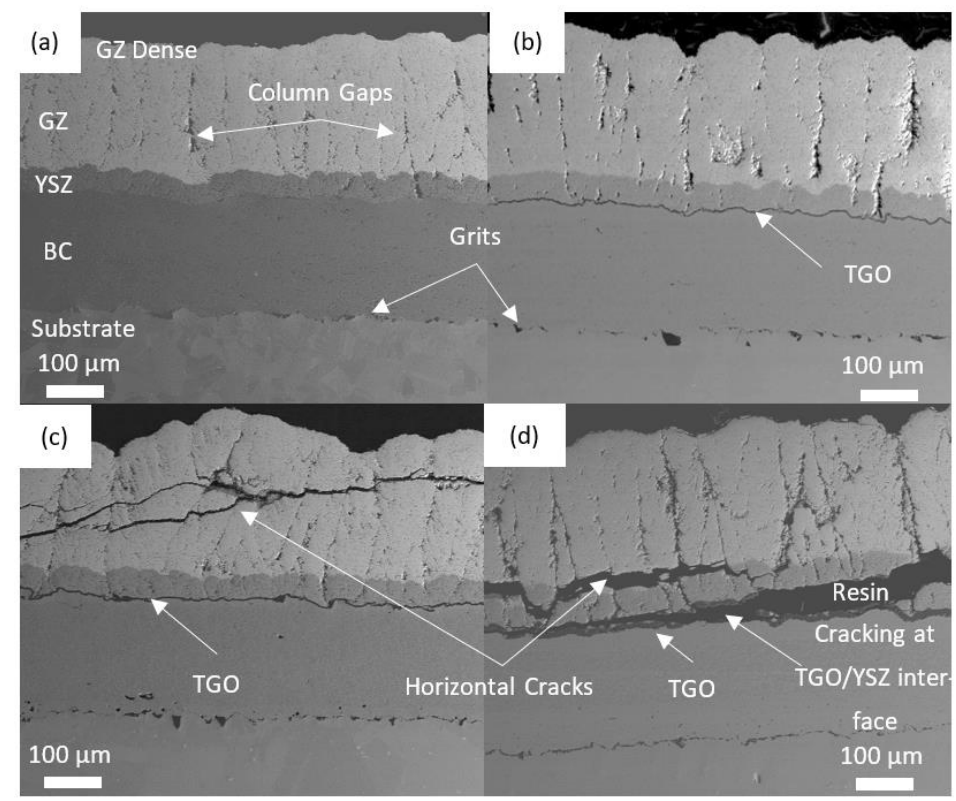
scale. Figure 4d shows the failure of TL-TBC after 100 h which can be recognized by cracking at the TGO/YSZ interface coupled with horizontal cracks developed within the GZ segment at approximately 60 µ m away from the TGO scale. Delamination of the coating was observed after 100 h as the TGO thickness exceeded the critical value.